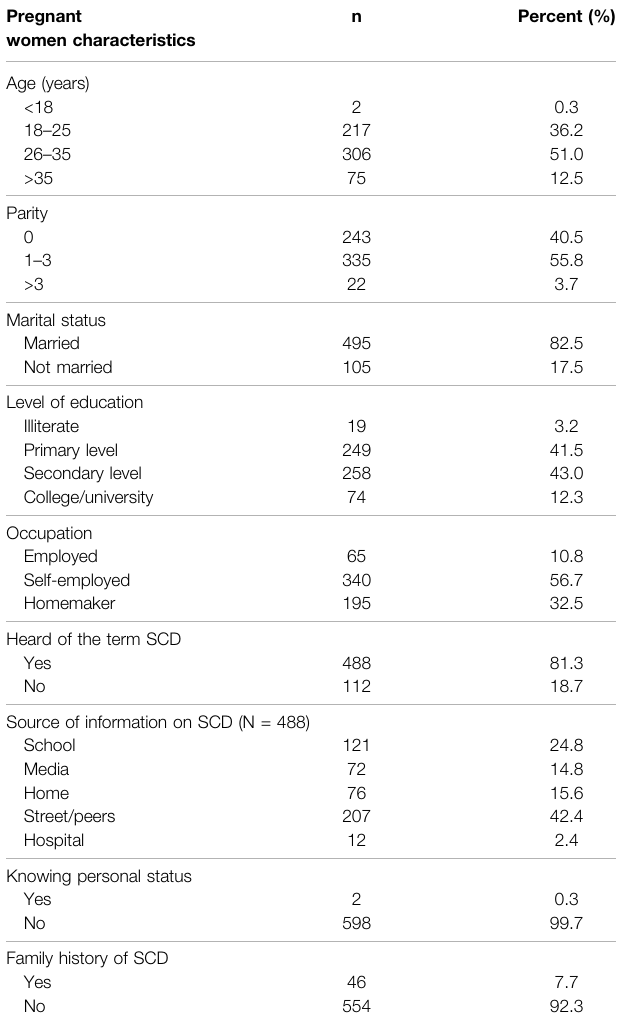
TABLE 1 | Socio-demographic characteristics of pregnant women attending antenatal clinics in Dar-es-Salaam (N = 600). Pregnant women characteristics